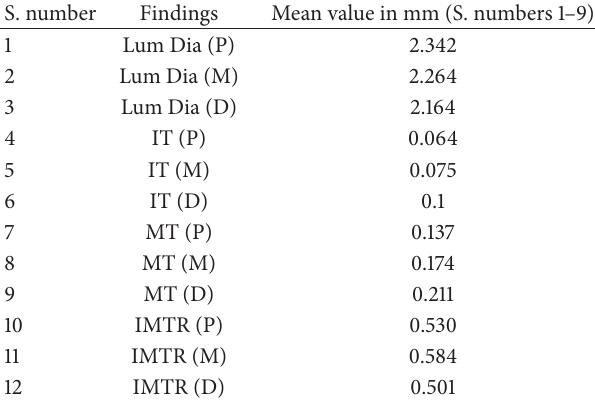
Table 2: Preoperative radial Doppler measurements; (Dia: diam- eter, D: distal, IMTR: intima-media thickness ratio, ITL intimal thickening, Lum: luminal, M: mid, MT: medial thickening, and P: proximal).